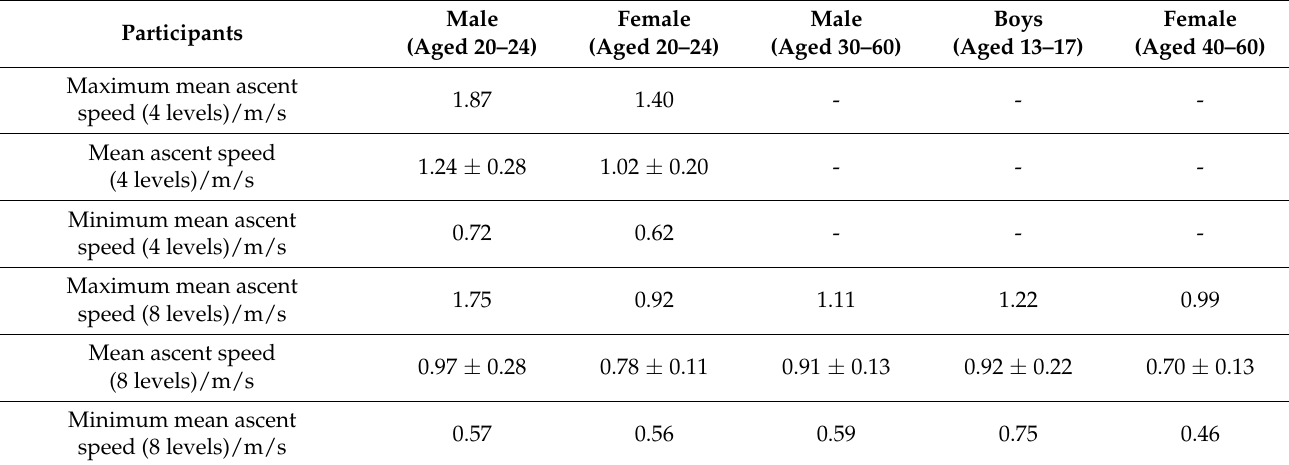
Table 2. Summary of the mean ascent speed.